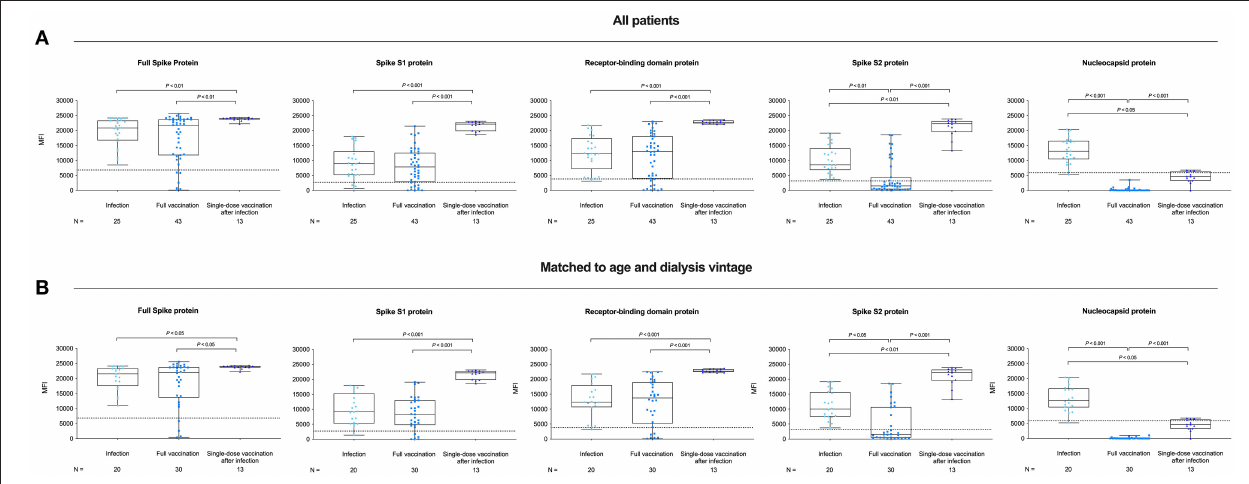
FIGURE 3 | IgG antibodies against different SARS-CoV-2 target antigens in hemodialysis patients after COVID-19 infection, complete BNT162b2 vaccination, and in previously infected patients receiving a single dose of BNT162b2. Bead-based detection of antibodies against the full spike, the S1 spike, the receptor-binding domain of the spike, the S2 spike, and the nucleocapsid protein of SARS-CoV-2 in all dialysis patients of different groups (A) and in an age- and dialysis vintage-matched subgroup analysis (B) . The x-axis represents the sample number, the y-axis the mean fluorescence intensity (MFI), and the dashed line indicates the cutoff for each SARS-CoV-2 target antigen in all patients (A) and in matched to age and matched to dialysis vintage patients (B) .